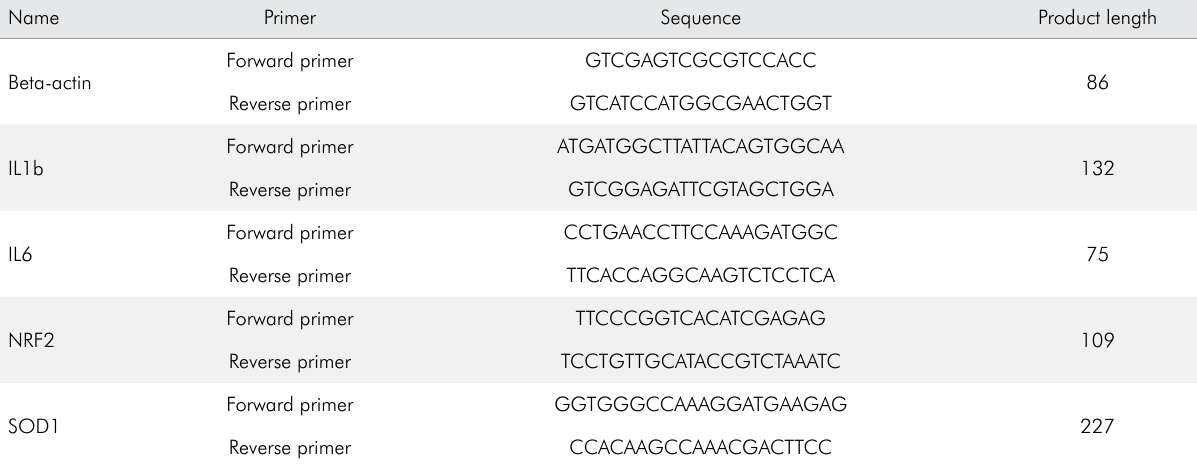
Table. Polymerase chain reaction (PCR) primer